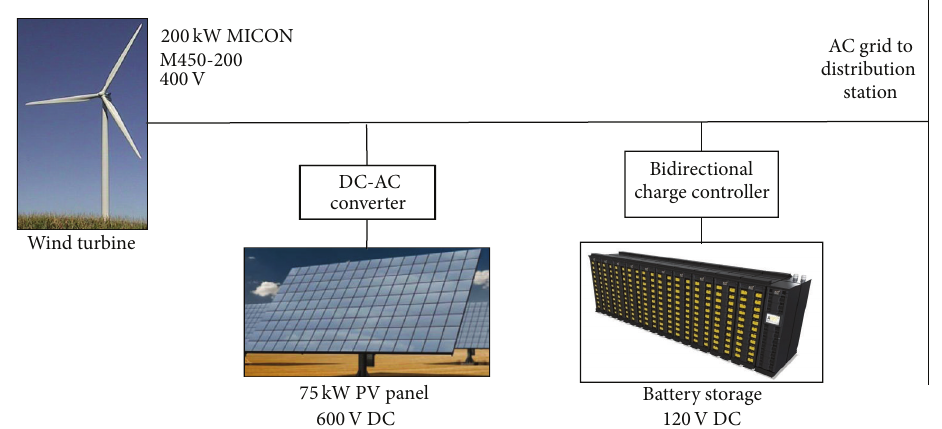
Figure 1: Schematic diagram of Hybrid Renewable Energy